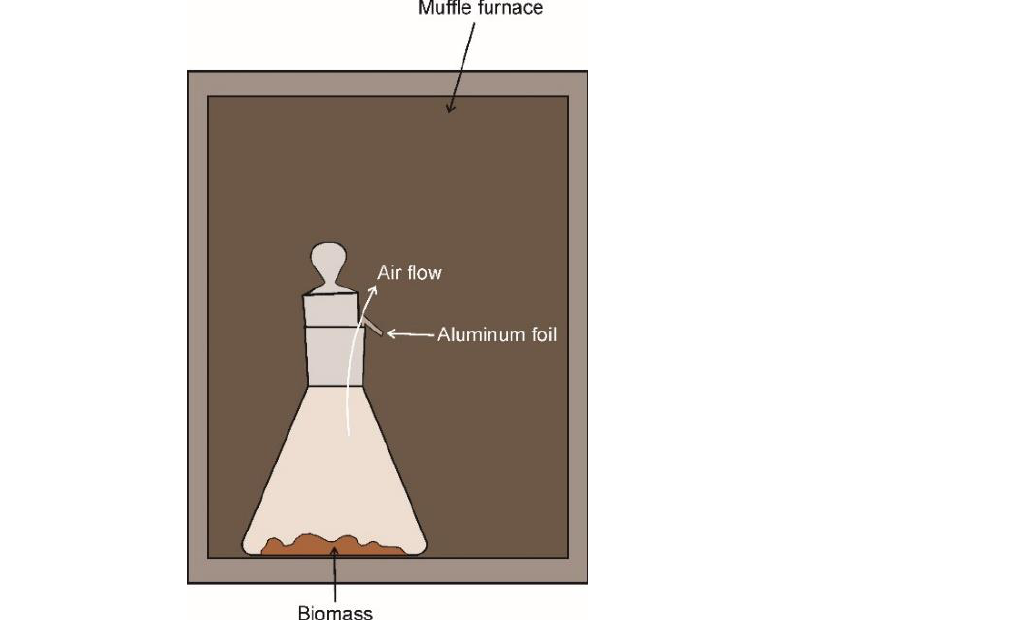
Figure A1. Lab–muffle–furnace biochar production. A few grams of air-dried biomass are placed in a Pyrex flask. The temperature is slowly raised to the desired value. Initially, the oxygen-containing air is still in the flask. Once the oxygen is consumed and the gas flows out from the container, the pyrolysis starts.